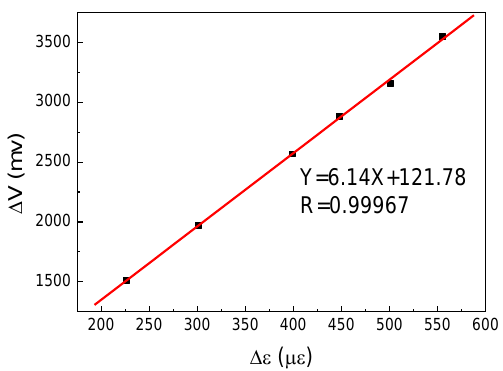
Figure 16. Sensitivity of the PVDF (5 Hz).